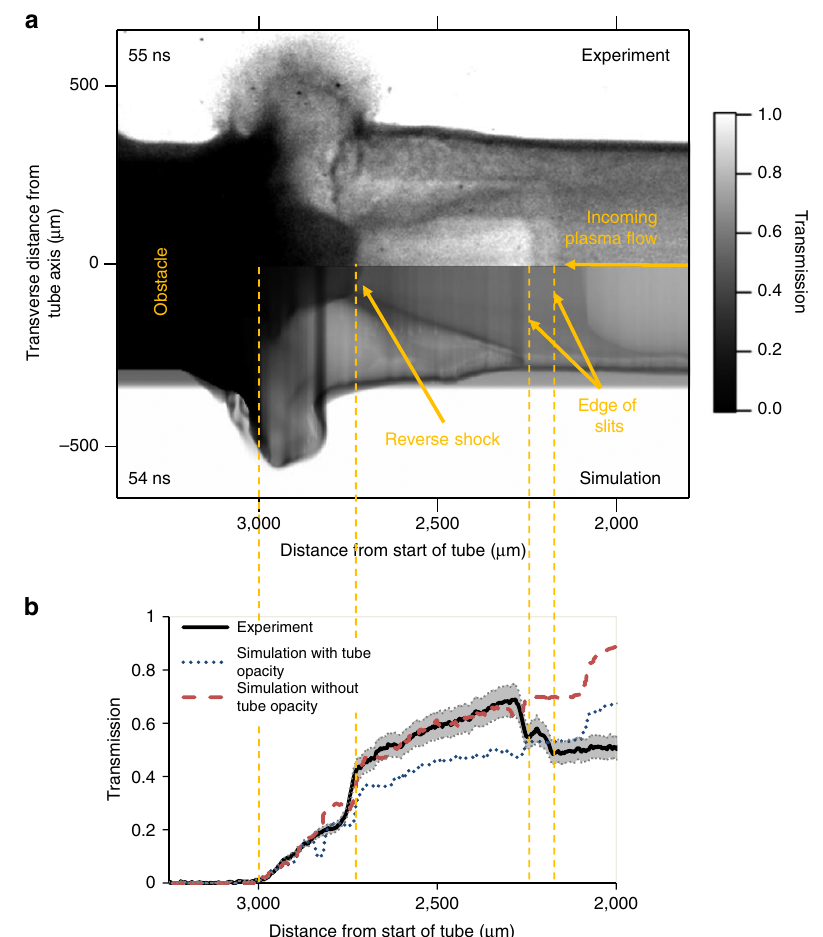
Figure 2 | Comparison of experimental and simulated results. A secondary target was used as an X-ray source for backlit pinhole radiography of the reverse shock region (see Fig. 1 and Methods). The plasma flow enters from the right of the figure and impacts onto the obstacle, originally at 3,000 m m, forming a reverse shock that can be seen around 2,750 m m. The top half of ( a ) shows the experimental radiograph, with the bottom half of ( a ) showing a synthetic radiograph from postprocessing a 2D simulation. The target tube had a slit cut into it from B 2,200 to B 3,100 m m. The same radiative hydrodynamic simulation was postprocessed to give simulated radiographs with and without the effect of the tube opacity, to account for the effect of the tube being absent at the slit position. A line-out of X-ray transmission along the central axis, for the experimental case and postprocessing of the simulated case with and without the opacity of the tube wall, is plotted in ( b ). The transmission is well matched for the experimental case and simulated radiograph without tube opacity from the position of the reverse shock, B 2,750 m m, to the edge of the slit, B 2,200 m m. After this point, the experiment transmission agrees better with the simulated radiograph including the tube